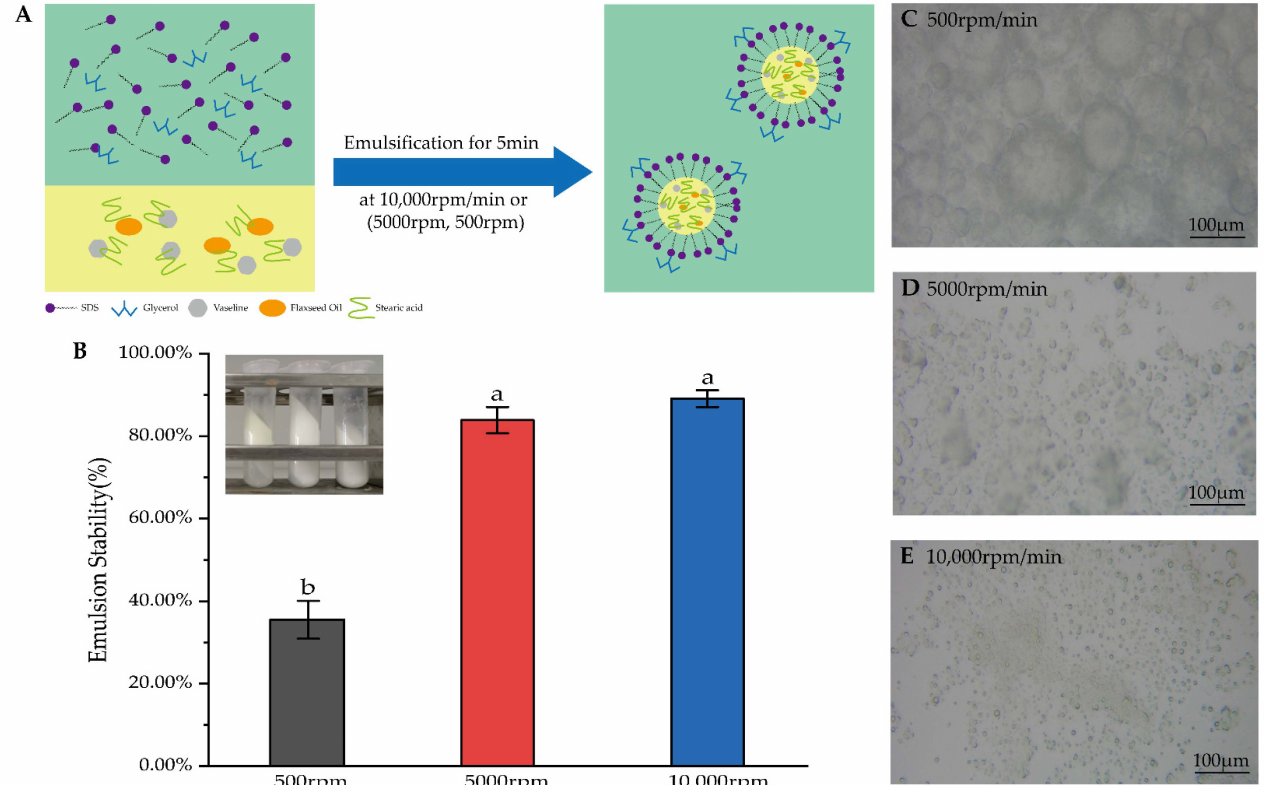
Figure 3. ( A ) Diagram of the preparation of the emulsion. ( B ) Results of accelerated emulsion stability and experimental figure at shear speeds of 500 rpm, 5000 rpm and 10,000 rpm. The data are means ± SD (n = 3). Means with different letters (a,b) are significantly different ( p < 0.05) via Duncan’s test. ( C – E ) Microphotographs of emulsions were mixed at 500 rpm, 5000 rpm and 10,000